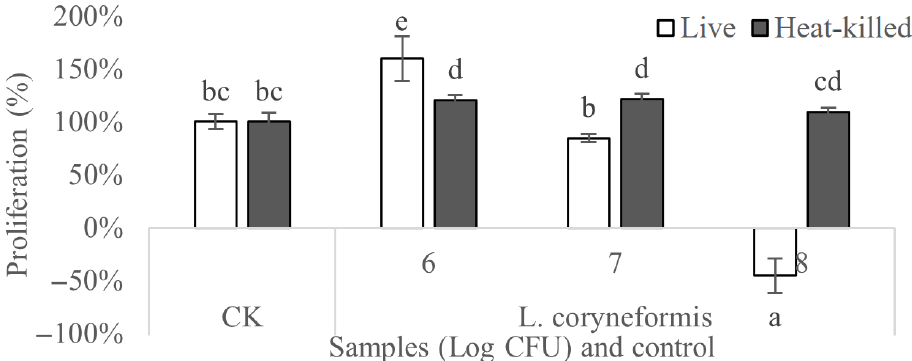
Figure 6. The anticancer activity of live and heat-killed Loigolactobacillus coryniformis NA-3 as evaluated using HT-29 cells. CK: Macrophages without treatment. Numbers 6, 7 and 8 on the abscissa: macrophages treated with different bacteria counts of Log CFU. a, b, c — Different lowercase letters mean significant differences ( p < 0.05).